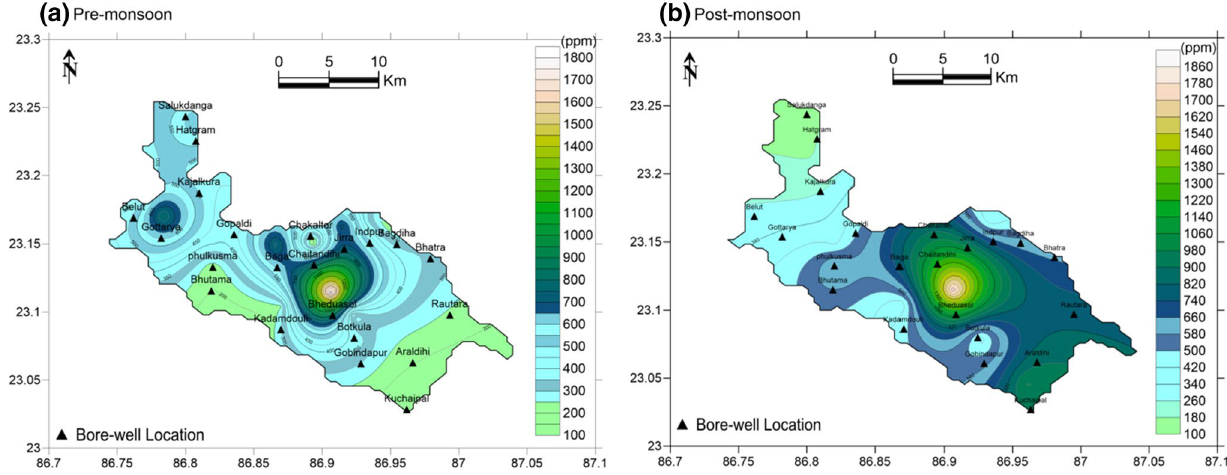
Fig. 6 Spatial variation of TDS a PrM; b